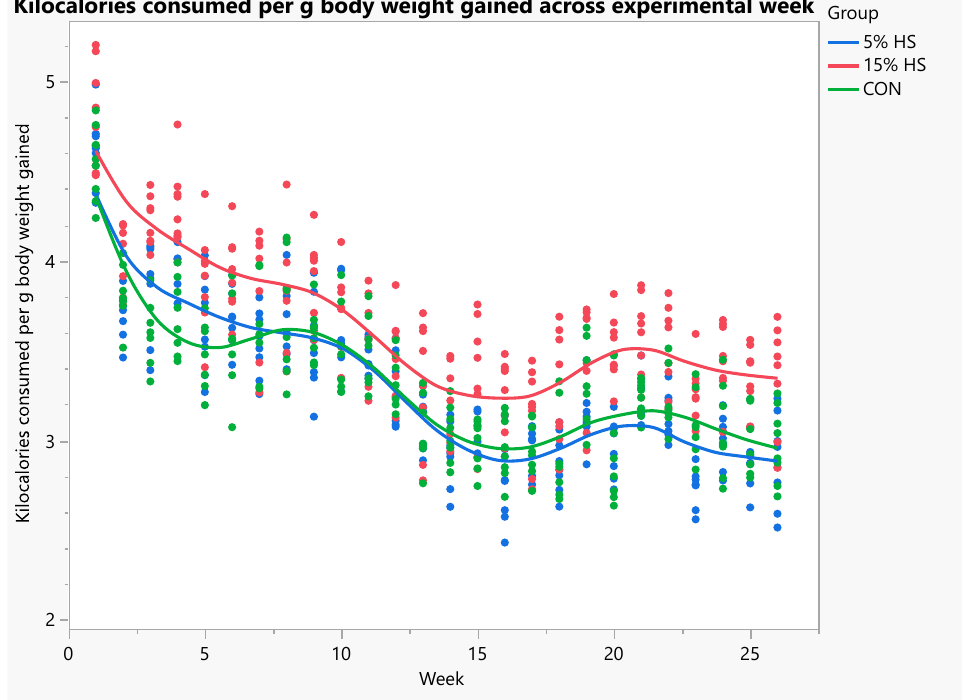
Figure 5. Kilocalories consumed per g body weight gained across experimental weeks. N = 8 per group. Each dot represents an individual mouse; colors represent the experimental diet group. Mixed models with repeated measures showed a significant effect of group, with 15% HS consuming significantly more kilocalories than the 5% HS and control groups ( p < 0.0001). Effect of week, p < 0.0001.